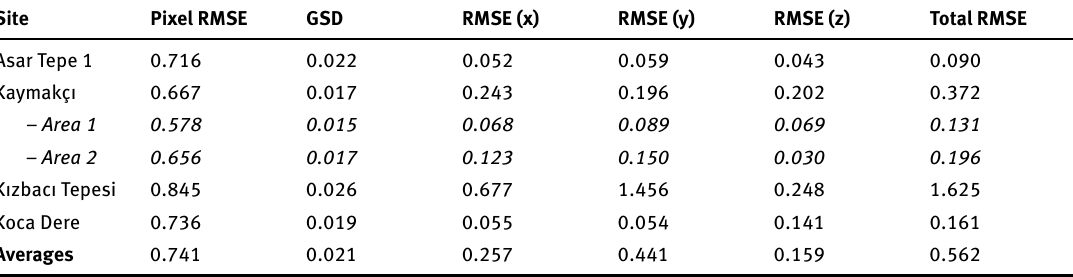
Table 5: Georeferencing accuracy of UAVP models produced in Agisoft’s PhotoScan Pro. Pixel root mean square error (RMSE) is provided in dimensions of pixels, while Ground Sample Distance (GSD) represents the ground dimension of an individual pixel in m. The total RMSE of x -, y - and z -coordinates estimated by PhotoScan Pro against GCPs established by RTK GNSS are pro- vided in m, along with the total RMSE in m for each individual dataset. The two areas of interest from Kaymakçı are excluded from all